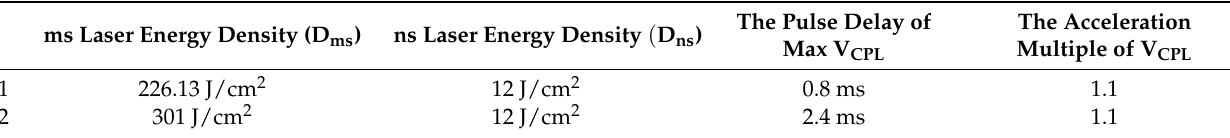
Table 1. The laser parameters of the maximum shock wave acceleration phenomenon.